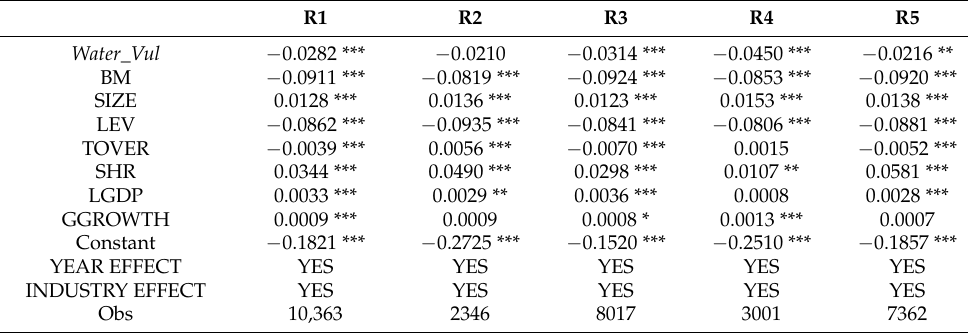
Table 6. The impact of water vulnerability on corporate financial